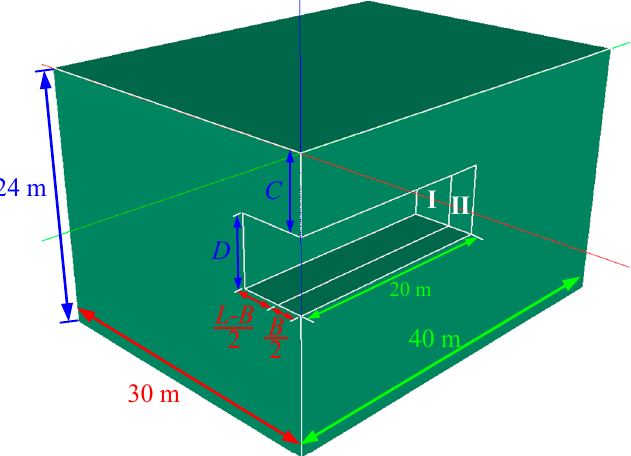
Figure 7. Geometry of the numerical model built in OptumG3. Table 1. Parameters for numerical modeling.